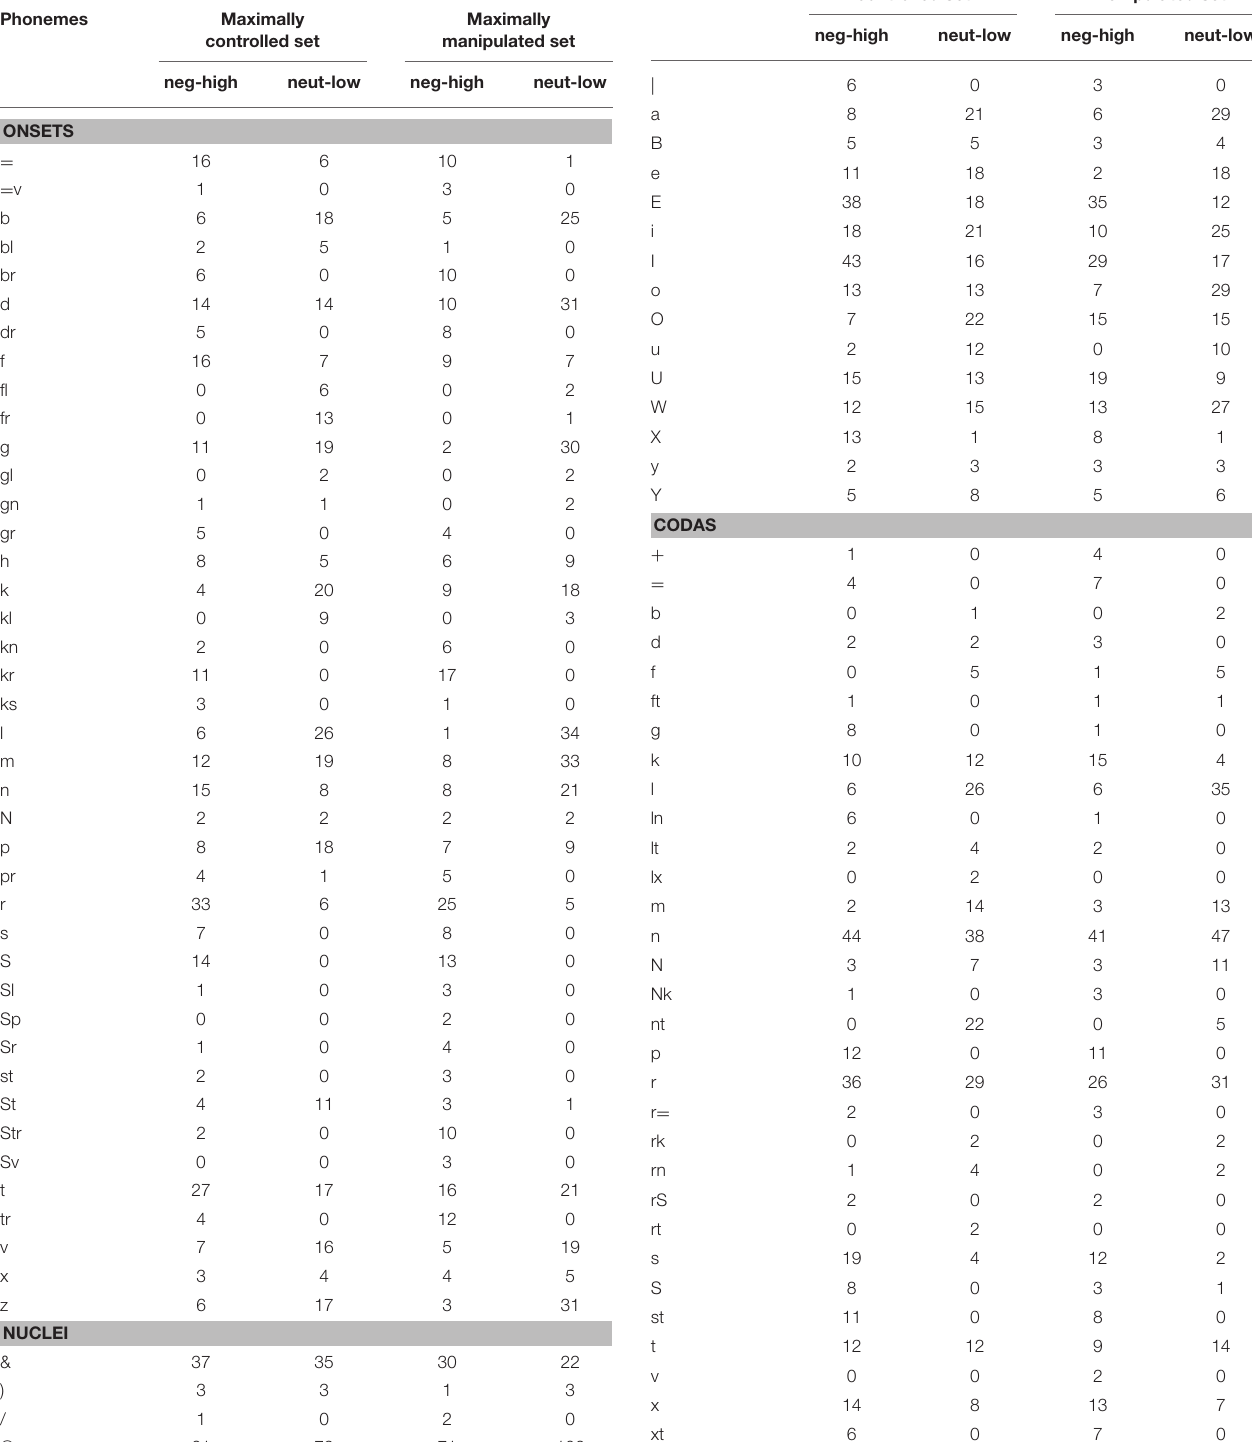
TABLE 2 | Phoneme (segments) distribution (in DISC Phonetic Encoding Convention; Burnage, 1990) across the conditions of sublexical affective potential in both stimuli